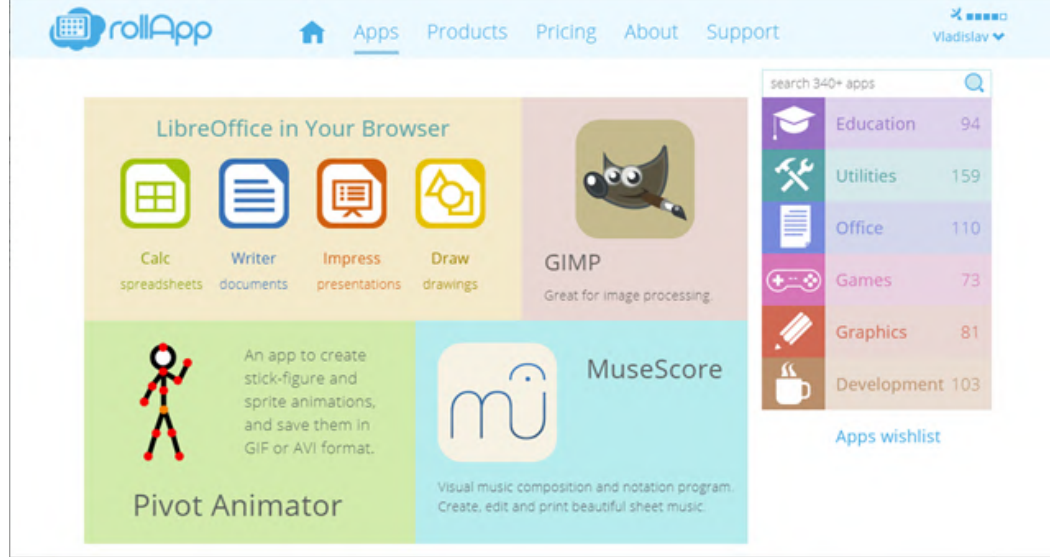
Figure 14: Presentation of paper